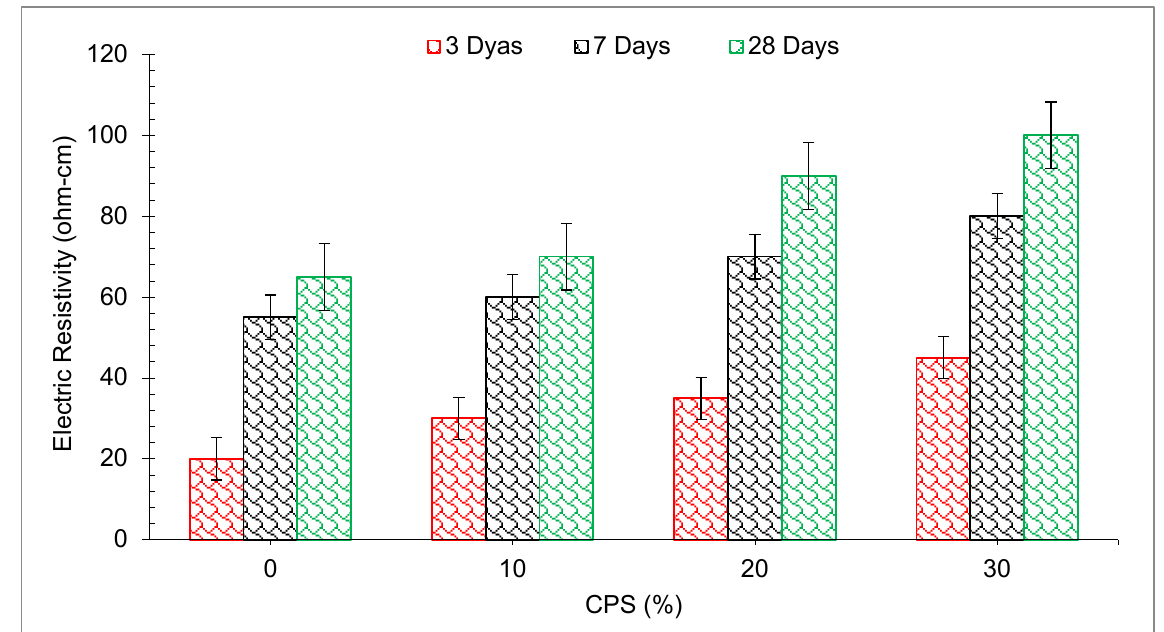
Figure 19. Electric resistivity of concrete: data source [64].